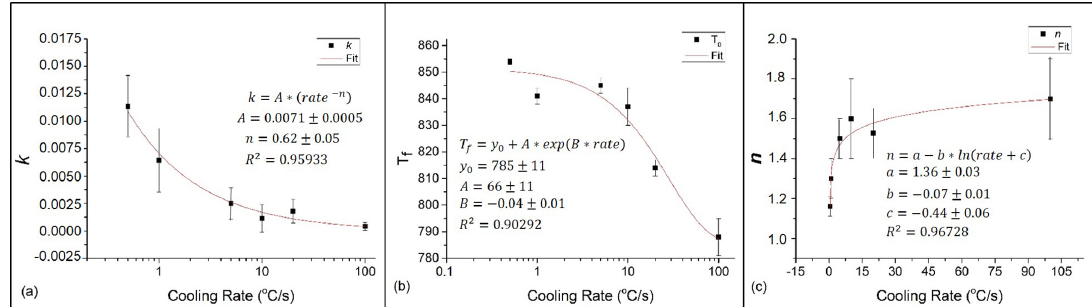
Figure 8. (a) Relation between the constant k and the cooling rate for the IF-Ti steel; (b) Relation between f T and the cooling rate for the IF-Ti steel; (c) relation between n and the cooling rate for the IF-Ti